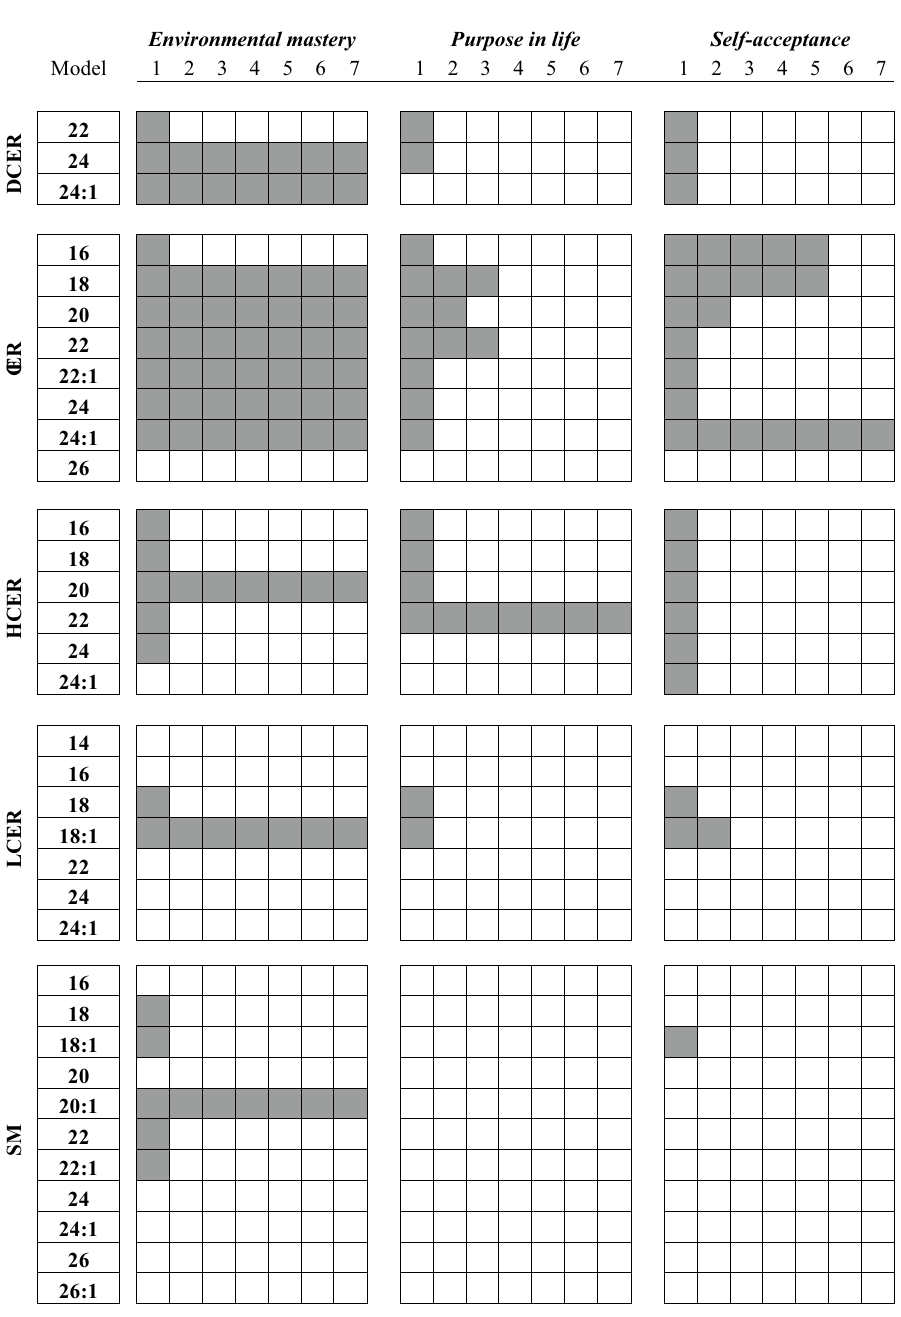
a person’s sphingolipid profile. We found that nutritional status and sleep quality can modulate and contribute to the observed associations.